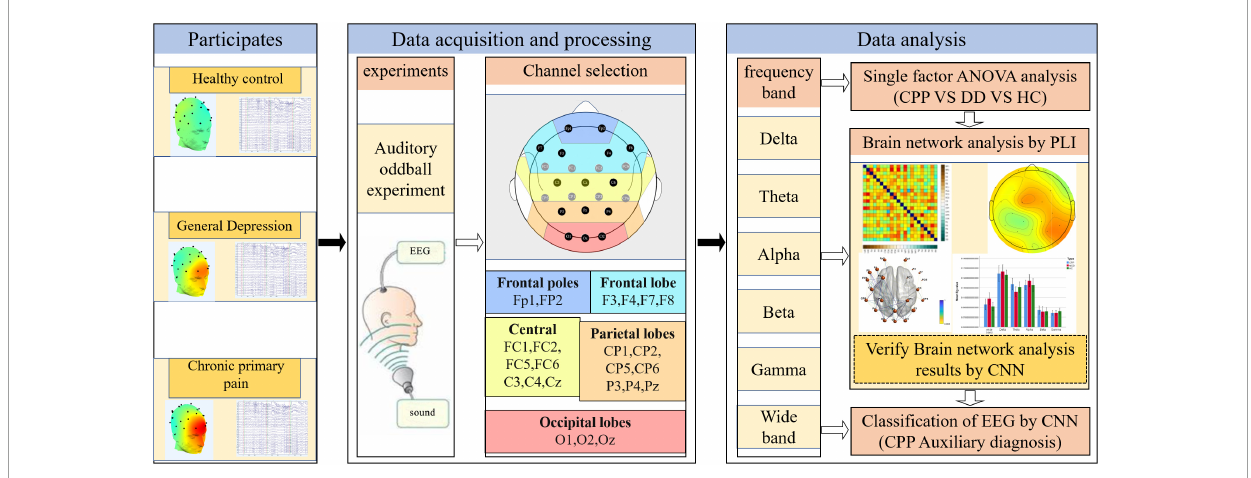
FIGURE1 Flow chart of research methods. Collect EEG generated by auditory oddball stimulation in three groups of subjects, and then select 23 channels of interest for brain network analysis and CNN classification.